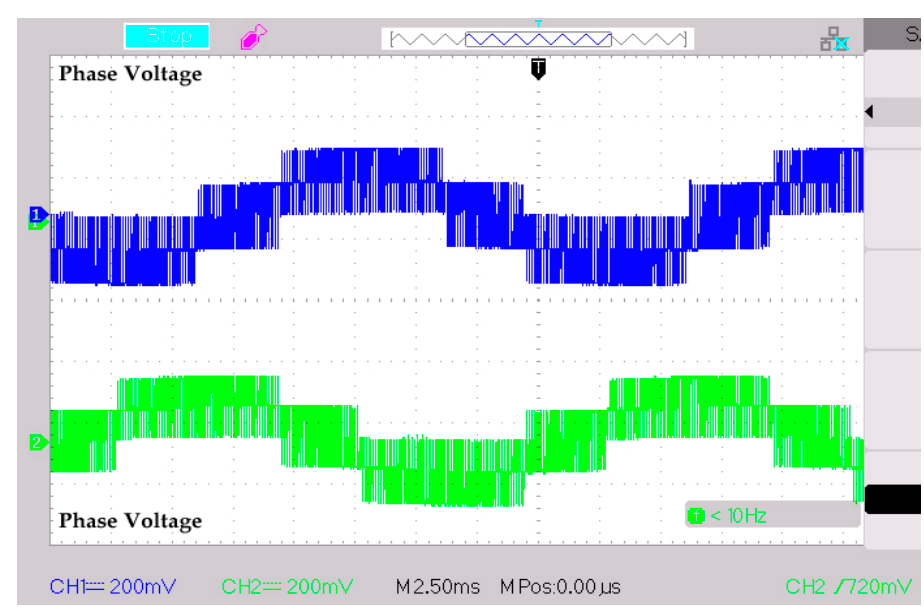
Figure 33. Line voltage and current at inverter output.